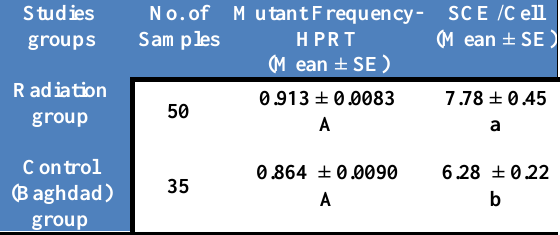
Similar latter in a column (for comparison between studies groups) mean there is no significant difference (P<